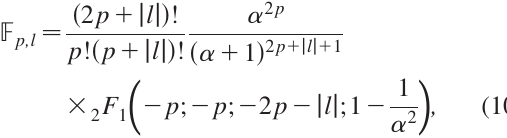
(cid:1) ¼ 0 , 0.5, 1, (cid:2) p